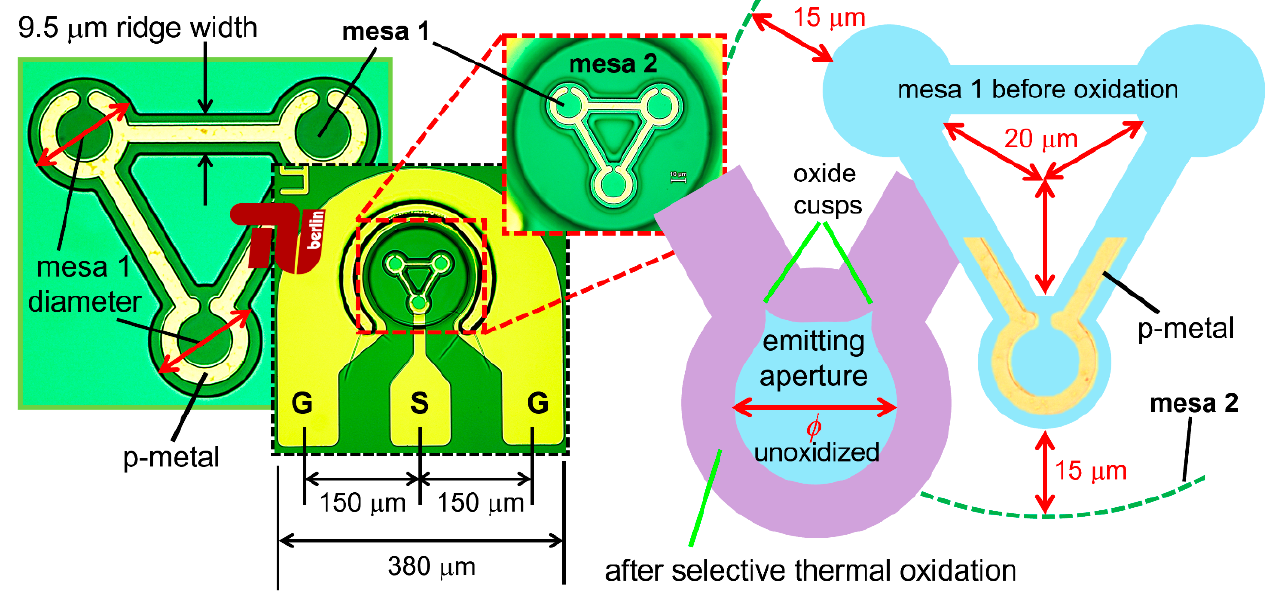
Figure 2. Illustration of the triple VCSEL array geometry via a collage of microscope images and schematics. We show unoxidized areas in light blue and oxidized areas in purple.